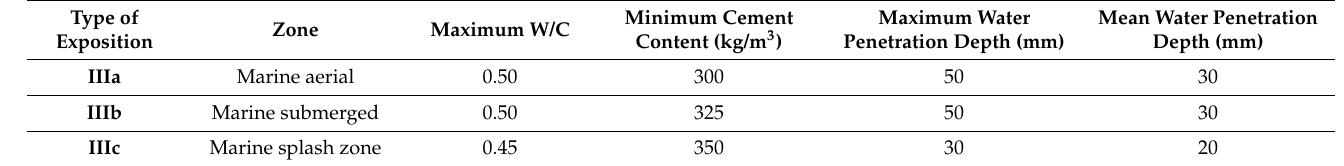
Table 2. Recommended cements for maritime and port construction projects